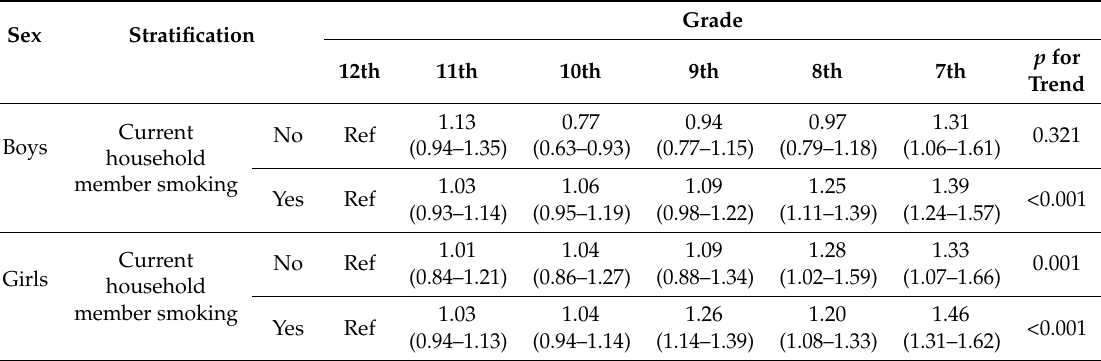
Table 3. The current household member smoker-stratified adjusted odds ratios a (95% confidence interval) for exposure to second-hand smoke at home according to grade by sex.